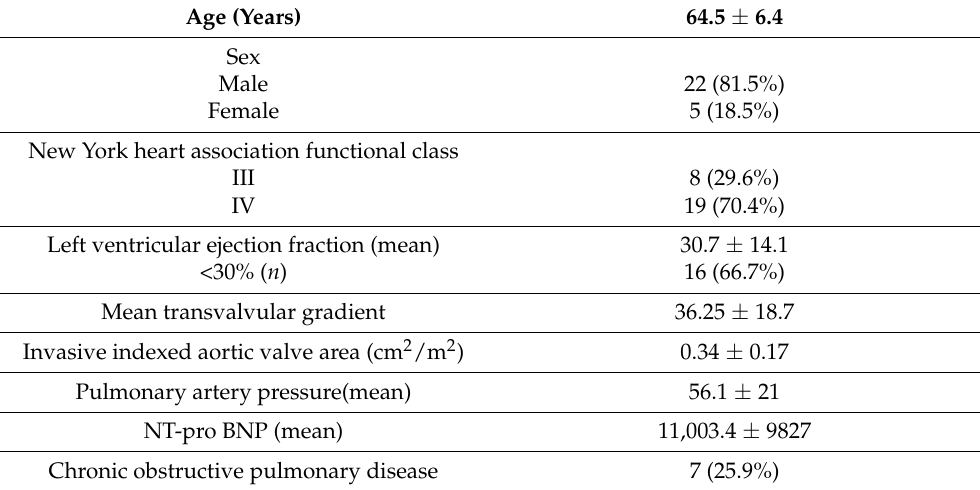
Table 1. Baseline clinical characteristics.